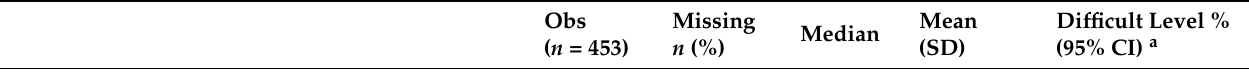
Table 5. Difficulty level of the translated Health Literacy Questionnaire (HLQ) in a Portuguese population